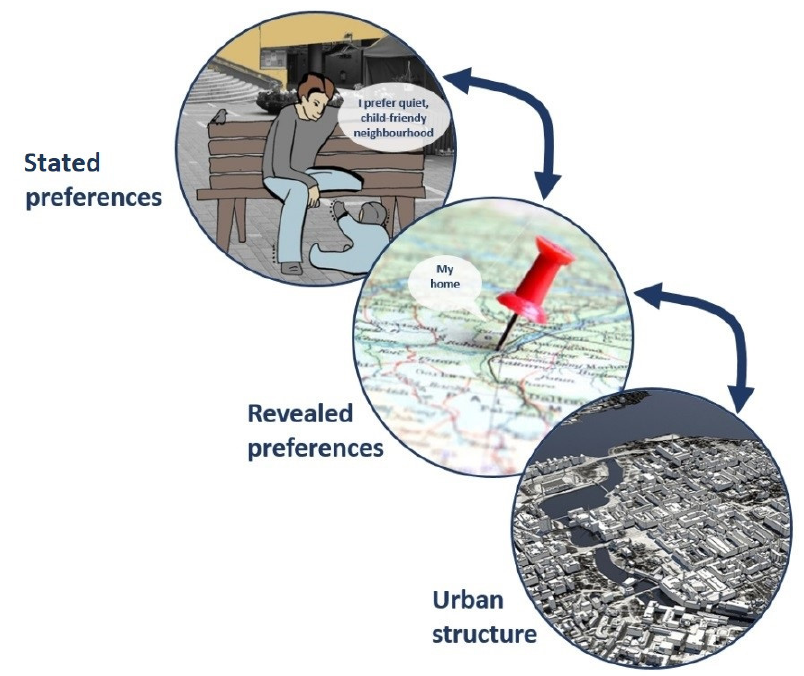
Figure 1. A conceptual overview of the study methods and the interaction between the three information